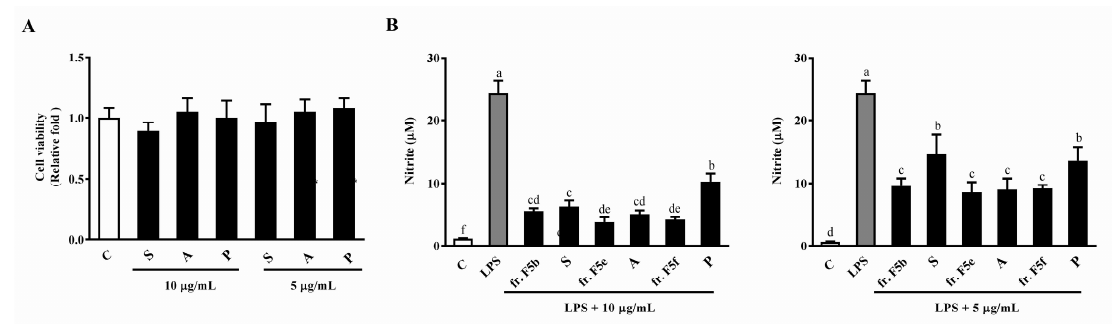
Figure 7. The effects of sitoindoside I, amentoflavone, and protocatechuic acid on cell viability and NO production in RAW264.7 cells. RAW264.7 cells were treated with various concentrations of frs. F5b, F5e, and F5f, sitoindoside I (S), amentoflavone (A), and protocatechuic acid (P) (10 and 5 μ g/mL) in the presence or absence of LPS (1 μ g/mL) for 24 h. ( A ) Cell viability was measured using the WST-1 assay, and the ( B ) NO production in cell culture supernatants determined using the Griess assay. The results are expressed as means ± SD from three independent experiments. For NO production: values with different letters indicate significant difference ( p < 0.05).